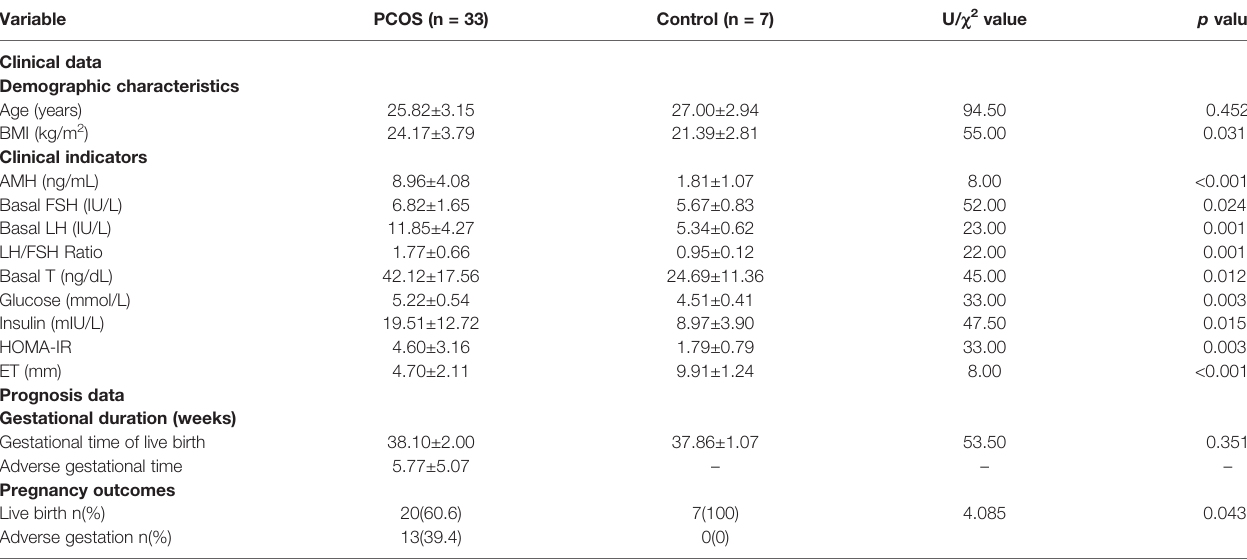
TABLE 1 | Clinical and prognosis data of patients with PCOS and controls.